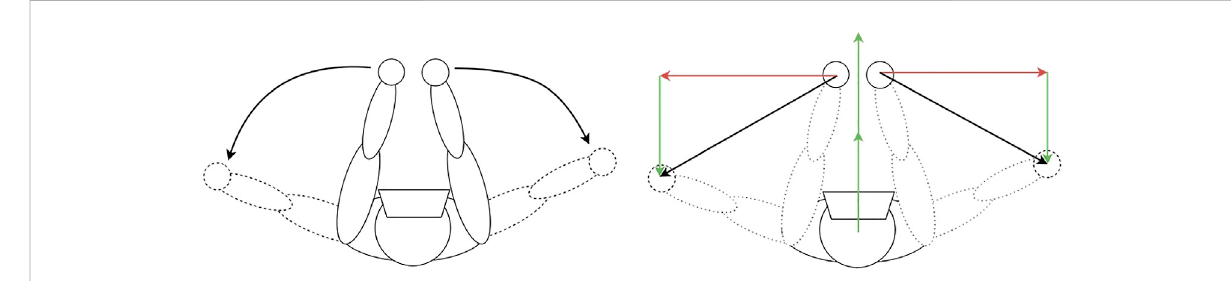
FIGURE 3 Conversion of real life breaststrokes to virtual propulsion vectors for immersive swimming and